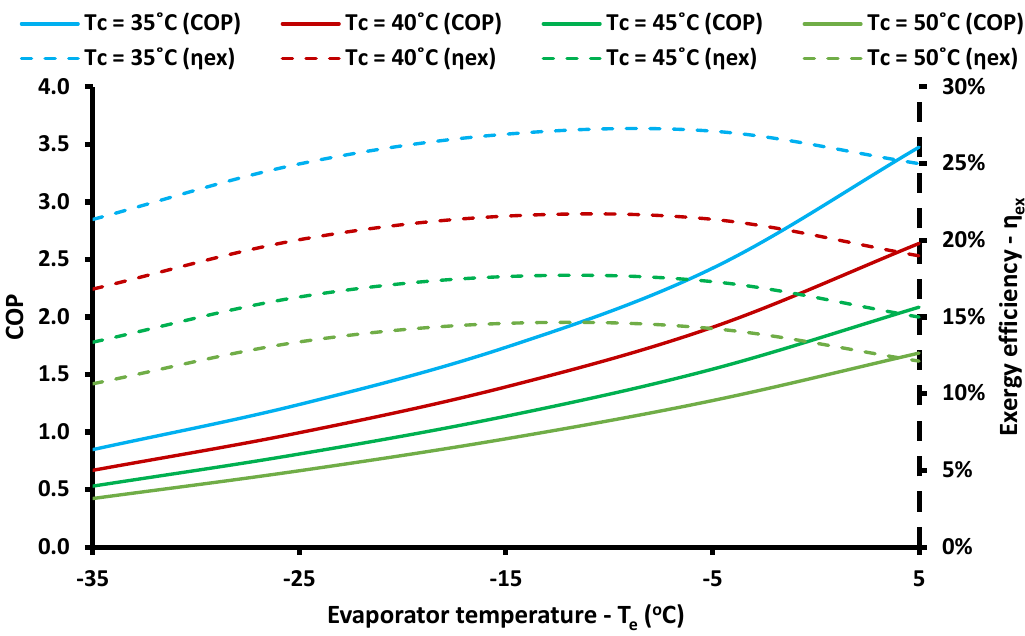
Figure 5. COP and exergy efficiency of the reference system for the examined optimized scenarios.